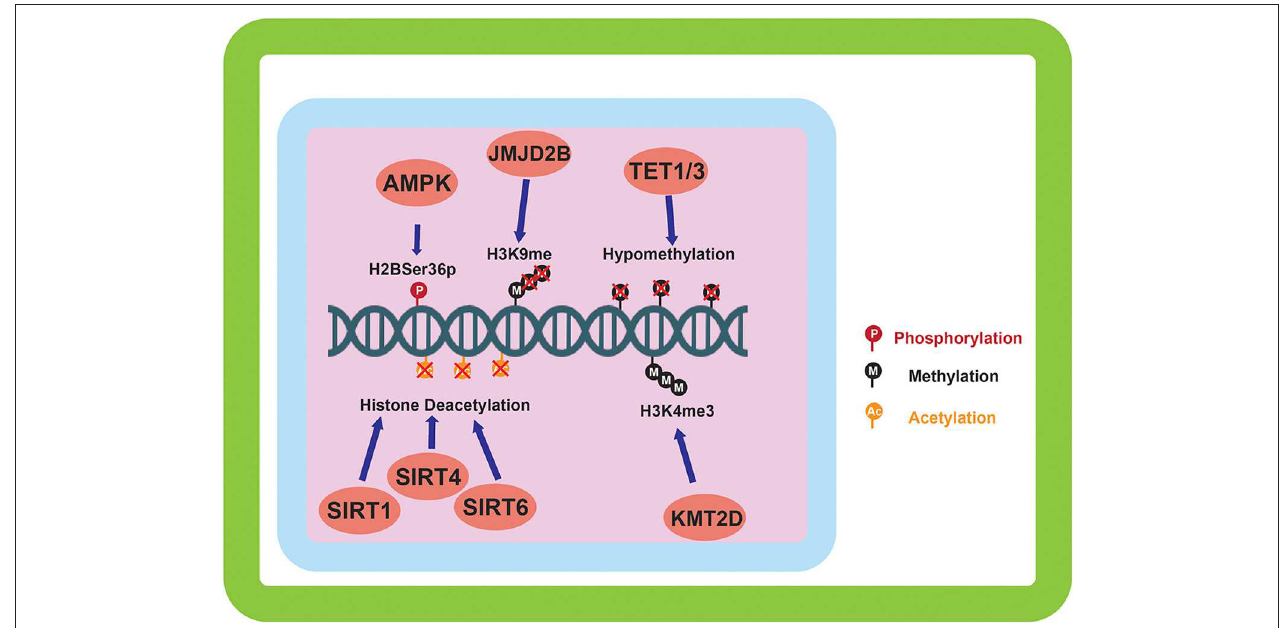
FIGURE 2 | Epigenetic alterations mediated by environmentally induced epigenetic modifiers. The epigenetic modifiers altered by the sensing of the cellular environment go on to carry out a variety of modifications to the epigenome. DNA methylation, and histone methylation and acetylation are the main downstream targets of the environmental sensing. Phosphorylation of histones by AMPK is also carried out in response to environmental